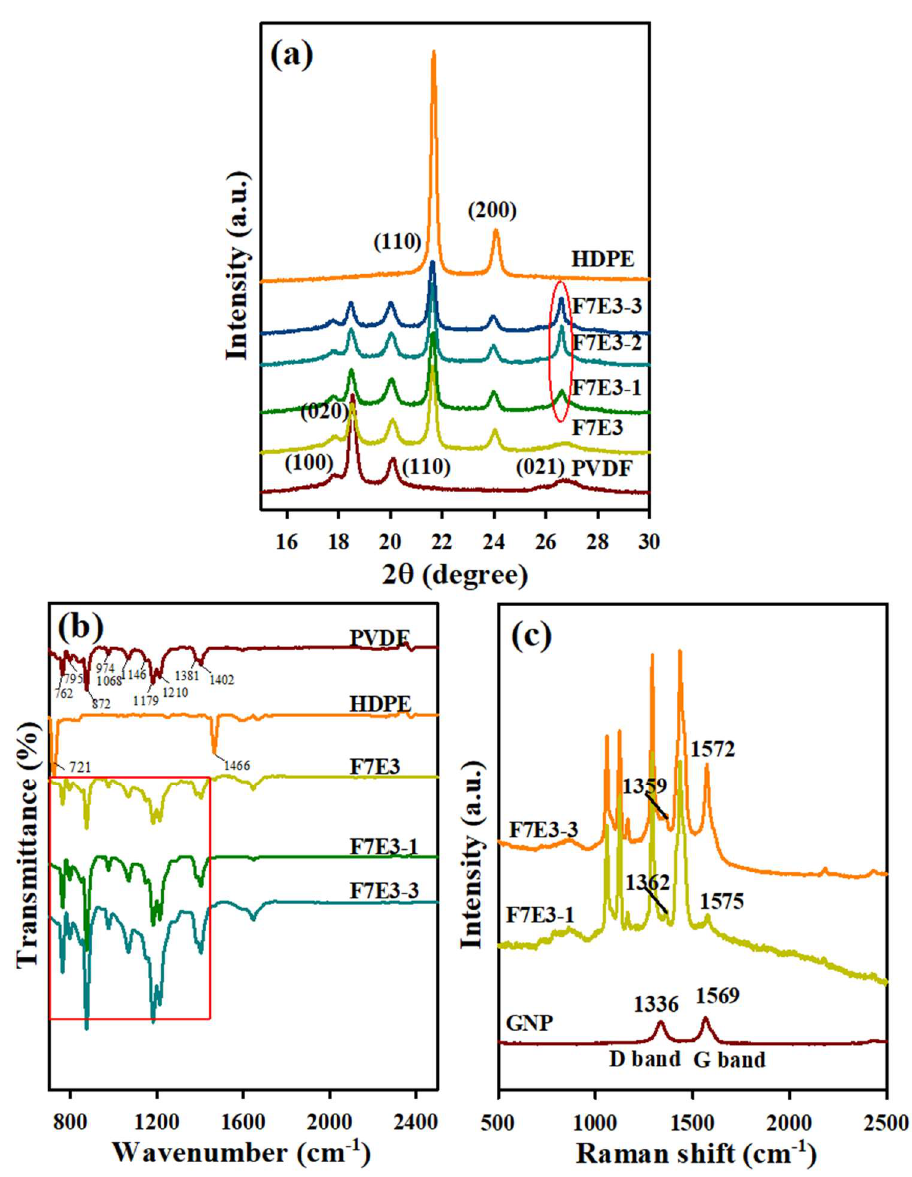
Figure 7. ( a ) X-ray diffraction (XRD) patterns of 5 °C/min-cooled representative samples; ( b ) Fourier-transform infrared spectroscopy (FTIR) spectra of selected samples; and ( c ) Raman spectra of GNP, F7E3-1, and F7E3-3.